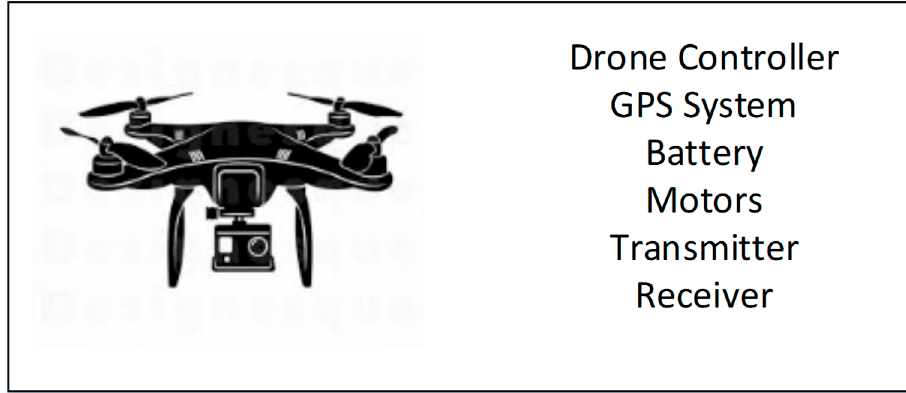
Figure 2. Drone Core Components.